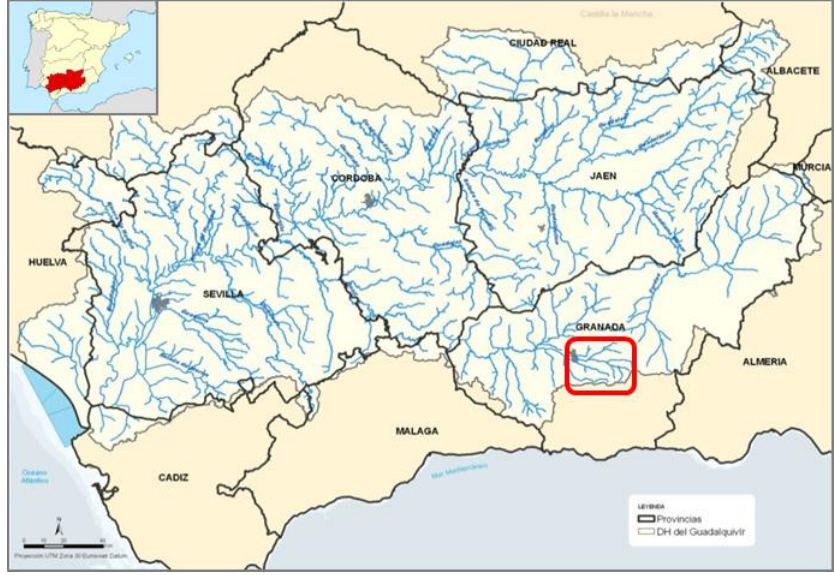
Figure 2 . Location of the Guadalquivir River Basin [31] in Spain and the area of study (Latitude: 37.15855 Longitude: